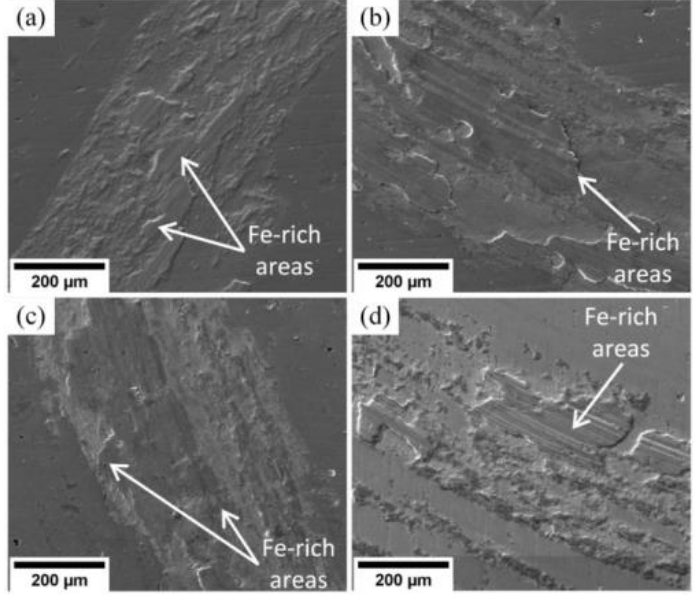
Figure 7. Wear tracks on the surface produced by the 100Cr6 counter body for substrates: ( a ) S1 (Al/Cr = 1.2), ( b ) S2 (Al/Cr = 0.8), ( c ) S3 (Al/Cr = 0.5), ( d ) S4 (Al/Cr = 0.2).